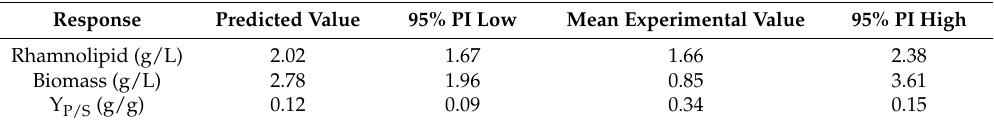
Table 10. Obtained experimental values of responses upon using optimum conditions as predicted by optimization of